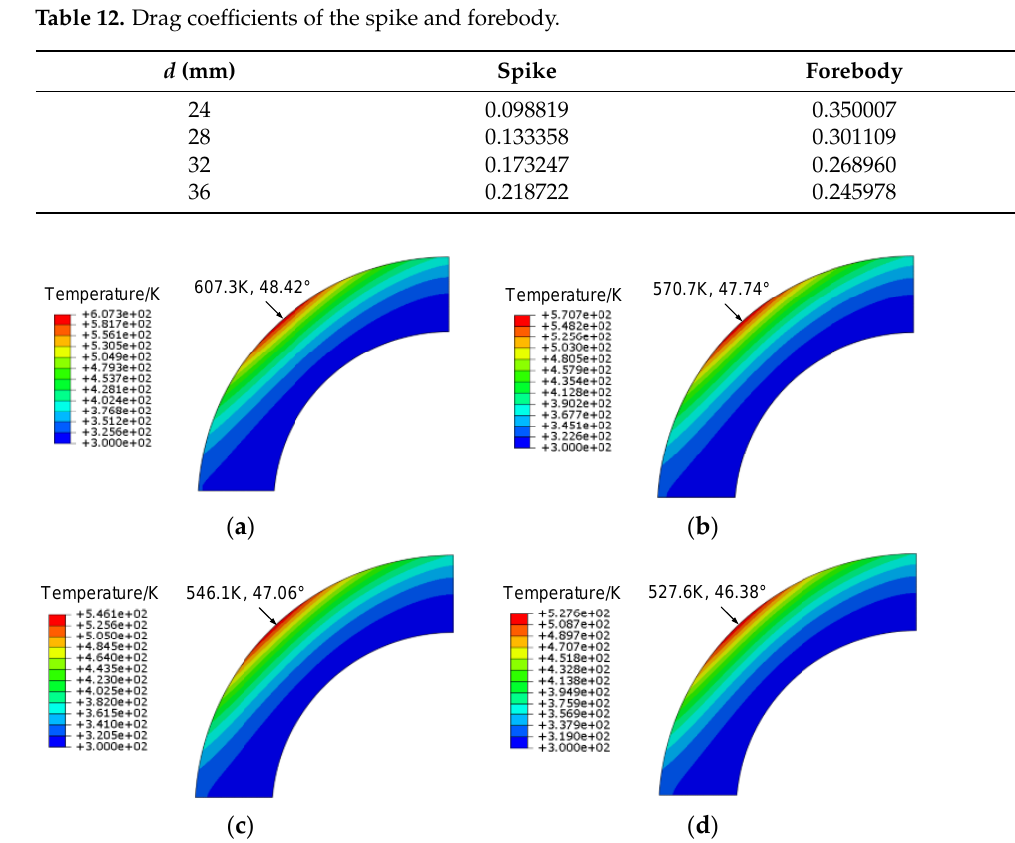
Figure 20. Comparison of the structural temperature field of the forebody at 20 s: ( a ) d = 24 mm; ( b ) d = 28 mm; ( c ) d = 32 mm; ( d ) d = 36 mm.